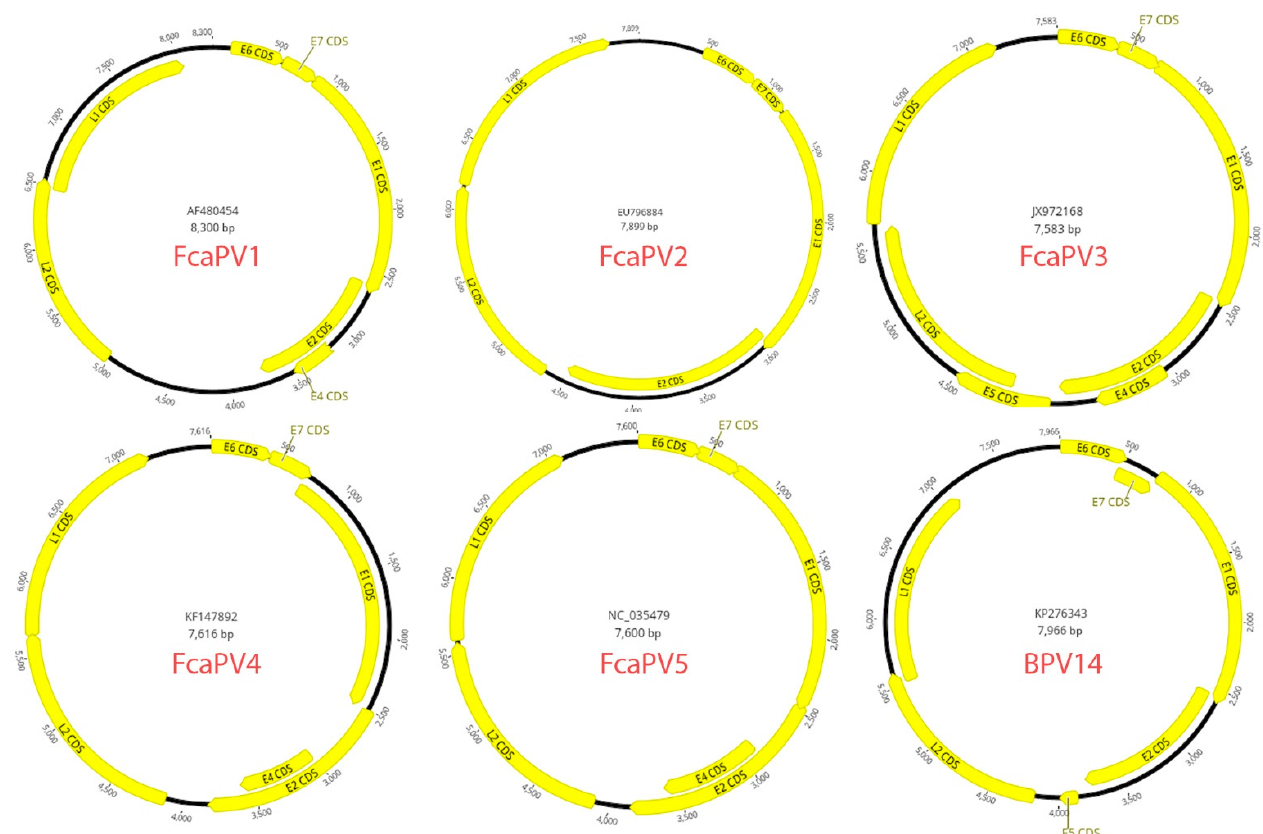
Figure 1. Schematic representation of the genetic arrangement of six of the seven papillomavirus types that are known to infect cats. Figures created using Geneious version 2021.2 created by Biomatters. Available from https://www.geneious.com (accessed 15 Aug 2021).